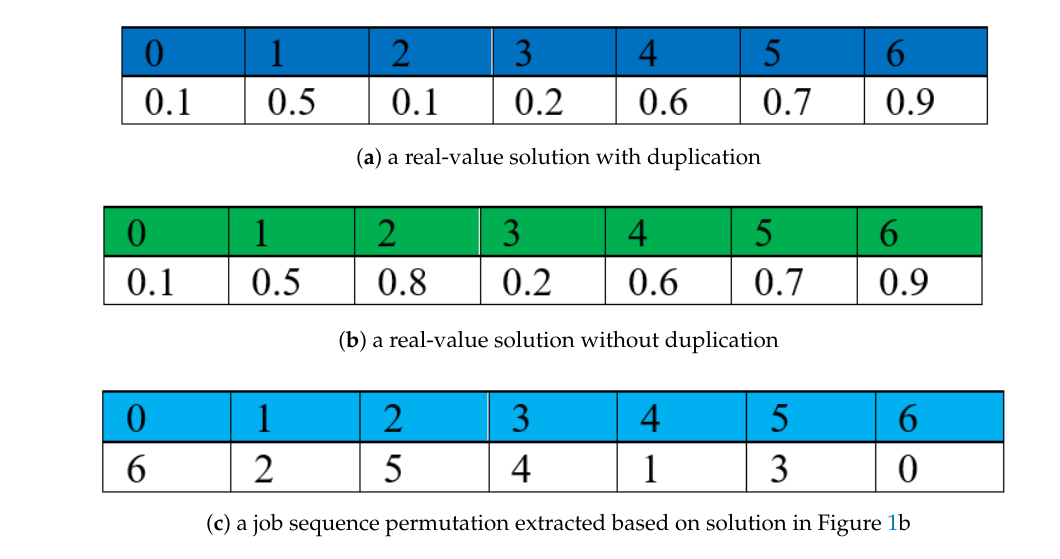
Figure 1. Illustration for a real-value